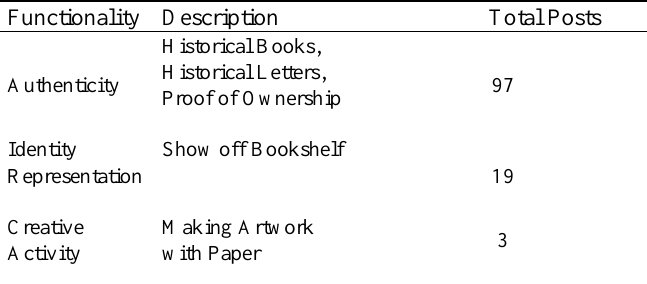
Table 1. Paper-based document competencies